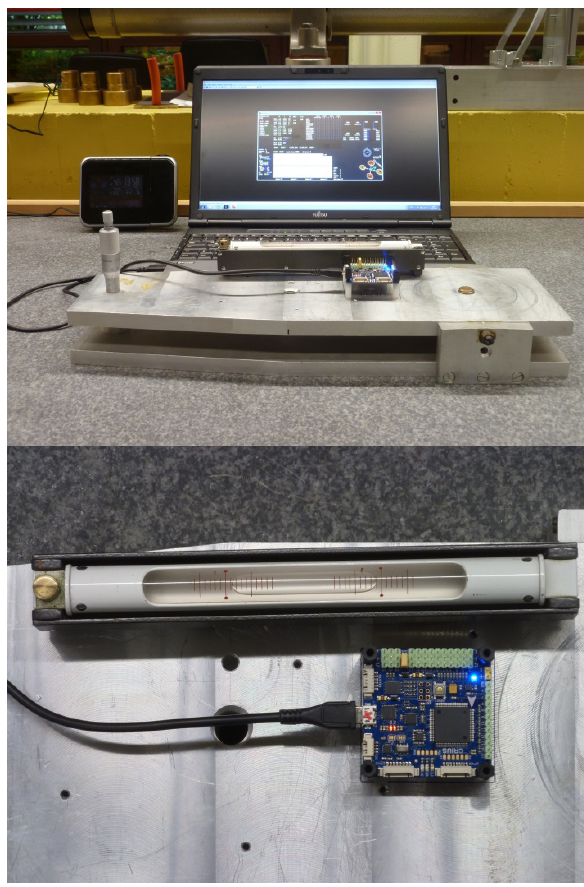
Figure 11. Mechanical board with a micrometer-srcew for the determination of the resolution of angles